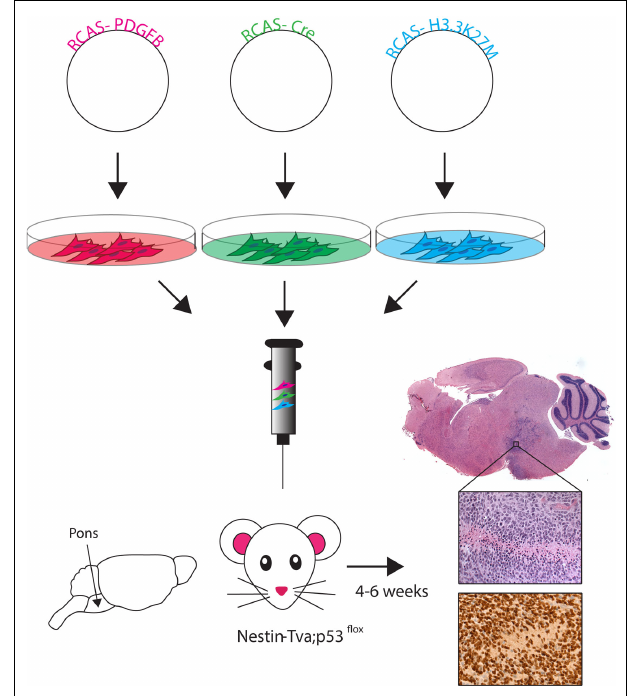
FIGURE 2 | RCAS-based modeling of DIPG . Schematic of the RCAS-based GEMM. Individual RCAS plasmids are transfected into virus producing cells. These cells are then directly injected into the brainstem of neonatal (Postnatal day 3–4) mice in an even ratio after stable virus production begins. Viruses selectively infect Nestin-expressing cells lining fourth ventrical of the brainstem. Tumor symptoms (e.g., loss of balance, enlarged head) develop within 4–6weeks. Histology using hemotoxylin and eosin (H&E) staining shows ventral brainstem location of tumor. High magnification (40 (cid:2) ) H&E image reveals high-grade tumor characteristics (pseudopalisading necrosis, mitotic figures, neovascularization), and immunohistochemistry image shows the HA-tagged H3.3K27M (nuclear) and PDGFB (cytoplasmic) expressing